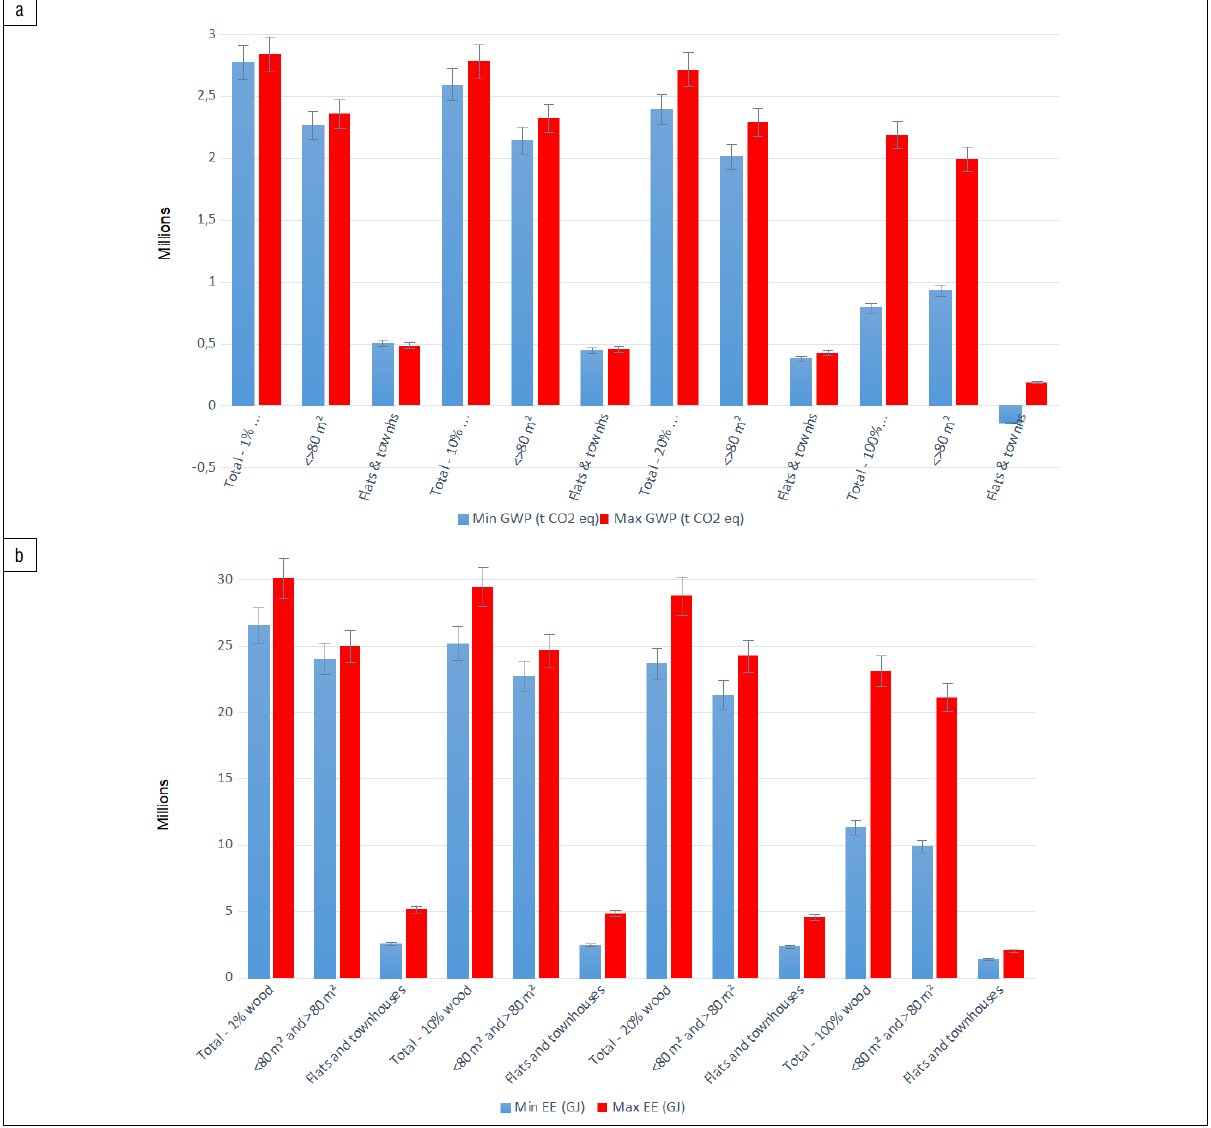
Figure 4: South African minimum and maximum annual residential building (a) global warming potential (GWP) and (b) embodied energy (EE) impacts, with 5% error